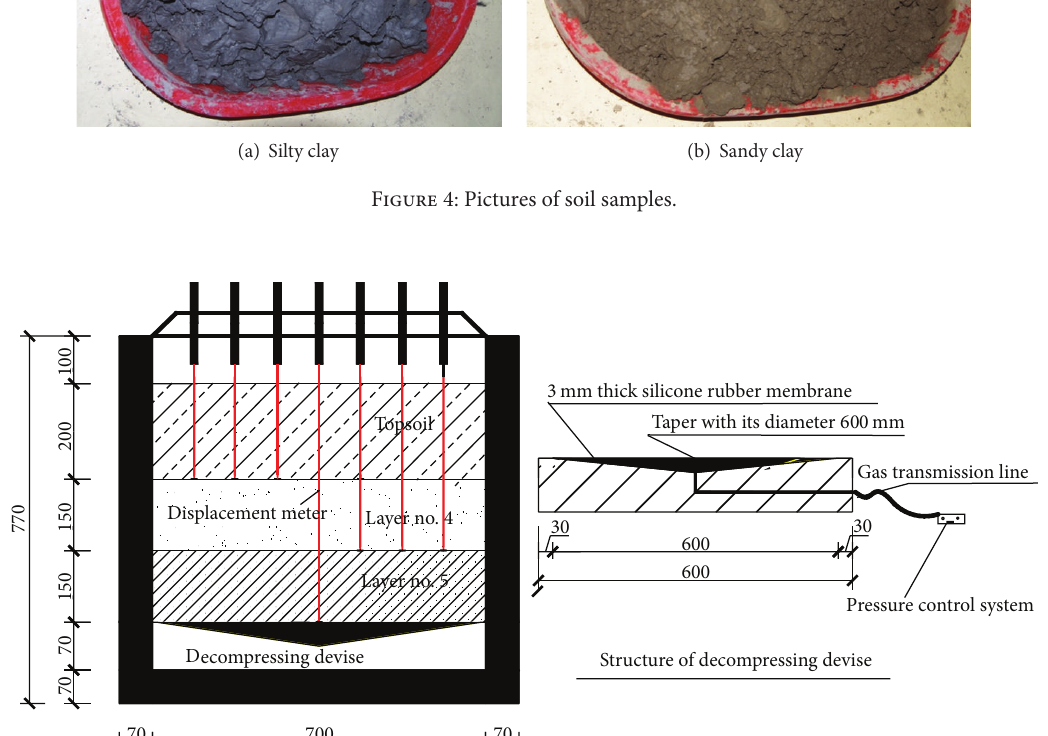
Figure 5: The distribution of stratum and decompressing devise in test model (unit: mm).